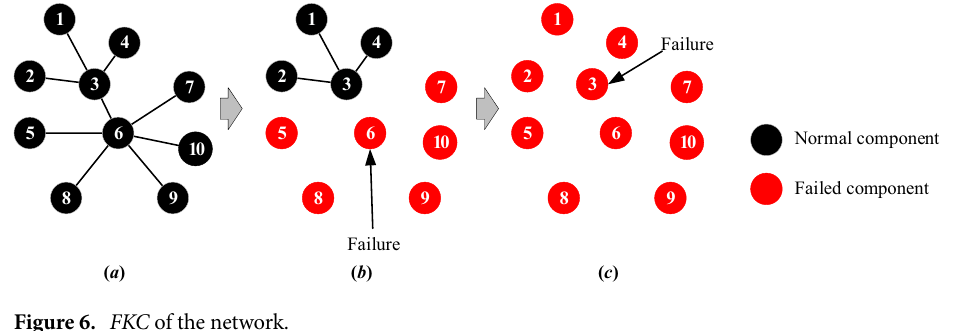
Figure 6. FKC of the